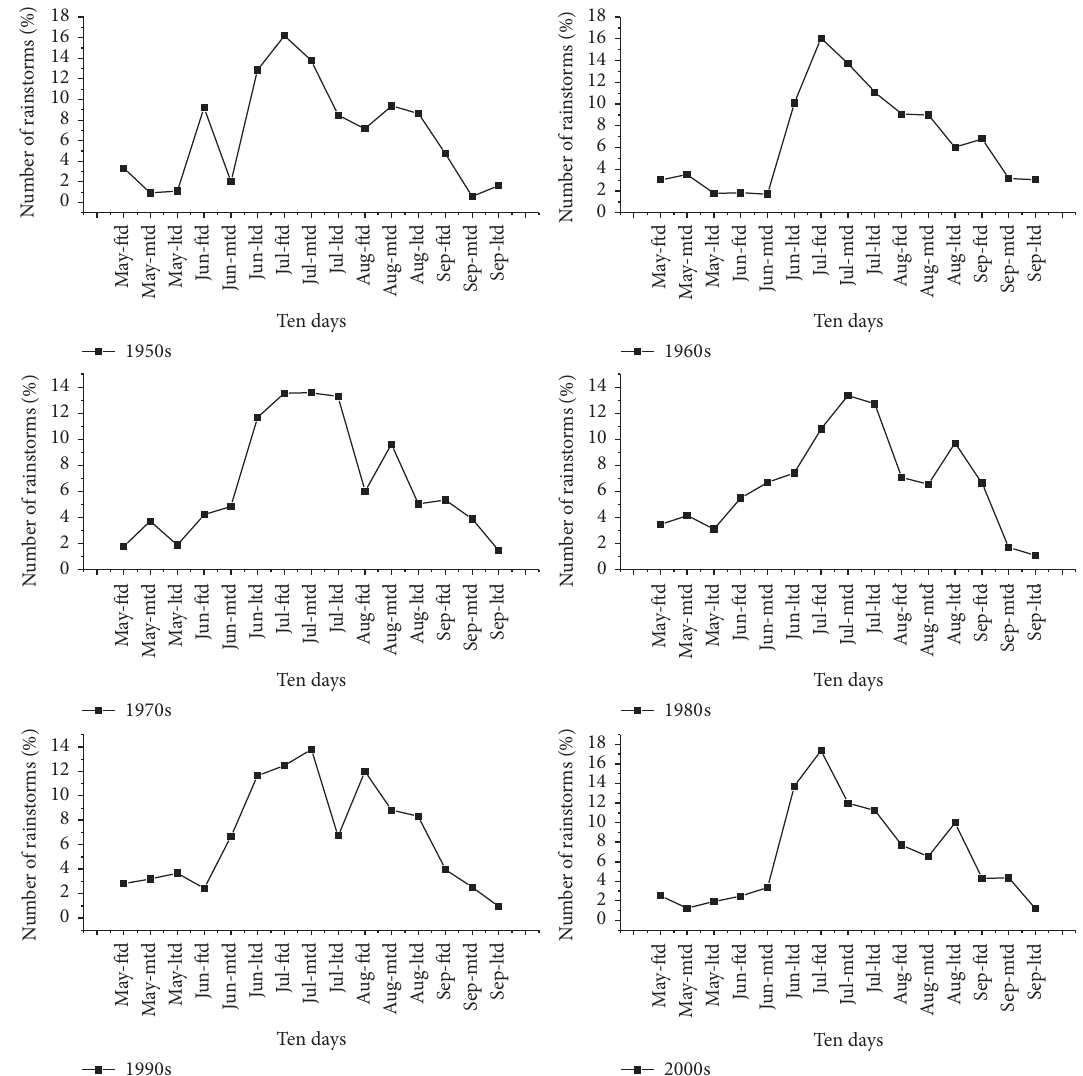
Figure 5: Variation of rainstorm events in ten-day intervals during